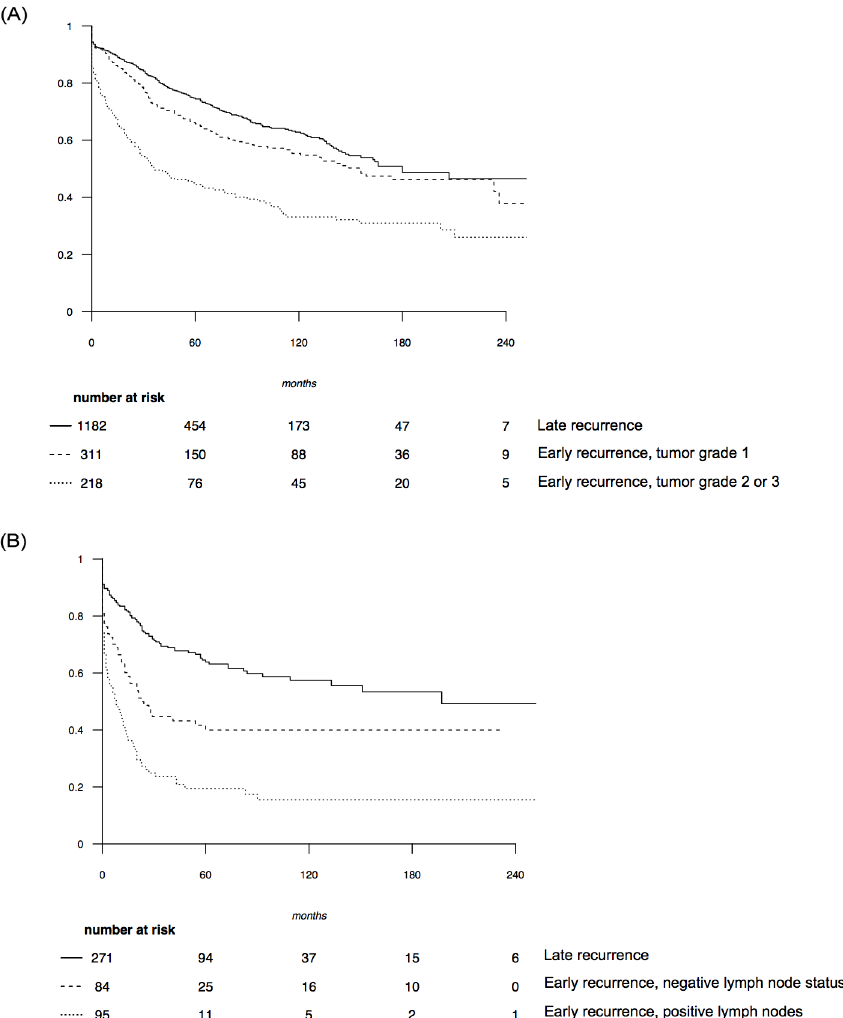
Fig 4. Distant disease free survival curves according prognostic subgroup. (A) Patients with hormone receptor positive tumors. (B) Patients with hormone receptor negative